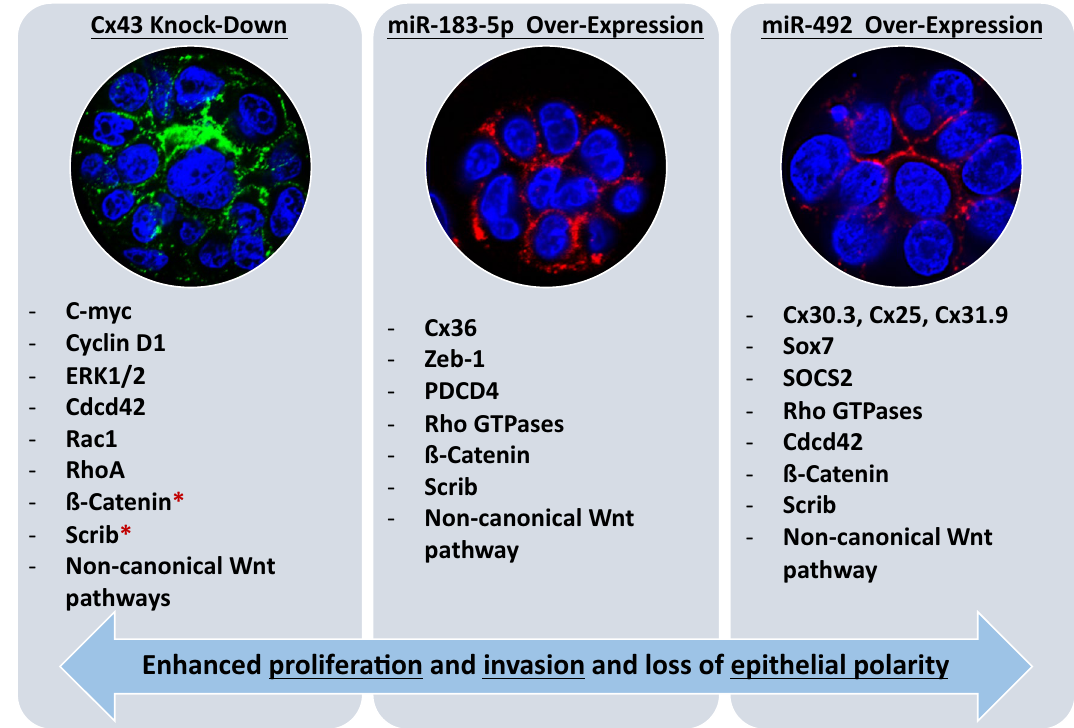
Figure 6. Comparative summary of validated and predicted players in increasing proliferation, invasion and disrupting epithelial polarity upon the loss of Cx43, over-expression of miR-183-5p or over-expression of miR- 492. The first panel represents major players/pathways that drive the pretumorigenic phenotypes observed in S1 cells upon Cx43 loss, as reported by Fostok et al. 30 and Bazzoun et al. 29 . All proteins were up-regulated upon Cx43 loss. The second panel represents major players/pathways that are predicted to drive the pretumorigenic phenotypes observed inS1 cells upon over-expression of miR-183. All genes were predicted to be down- regulated. The third panel represents major players/pathways that drive the pretumorigenic phenotypes observed in S1 cells upon over-expressing miR-492. All reported genes were predicted to be down-regulated. * denotes that total levels were unaffected but their localization along the cell was altered. Each cell line is illustrated by a representative acinar aggregate devoid of lumen formation and with mislocalization of β-catenin (green in the left panel and red in the rest) from apicolateral membrane domains in glandular structures or acini formed in 3D culture, suggesting the loss of apical polarity. Nuclei were counterstained with DAPI